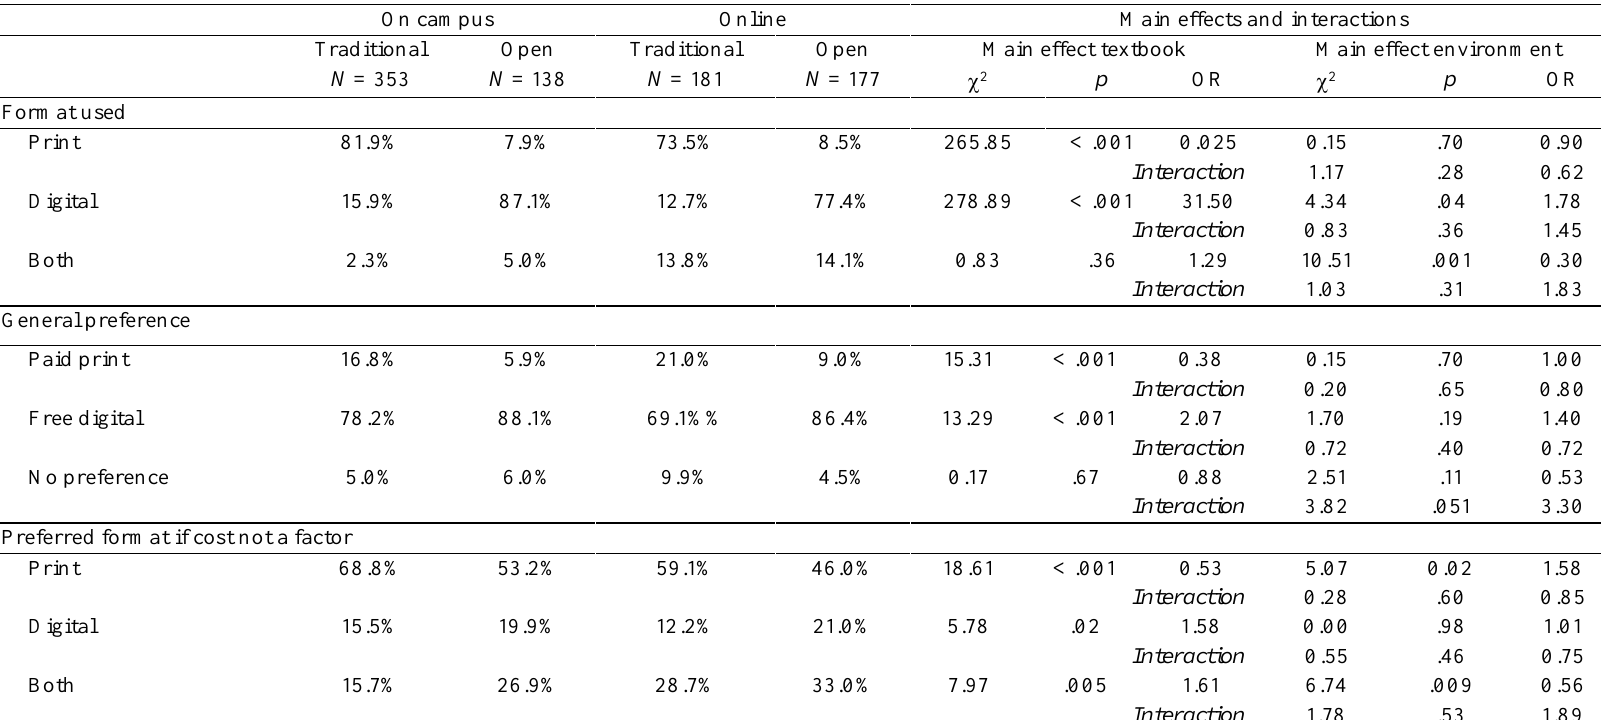
Use of and Preferences for Digital Versus Printed Textbooks Across the Four